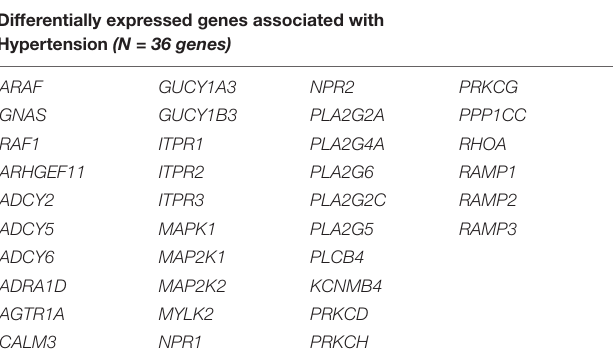
TABLE 1 | Genes into vascular smooth muscle altered by hypertension that could alter contraction